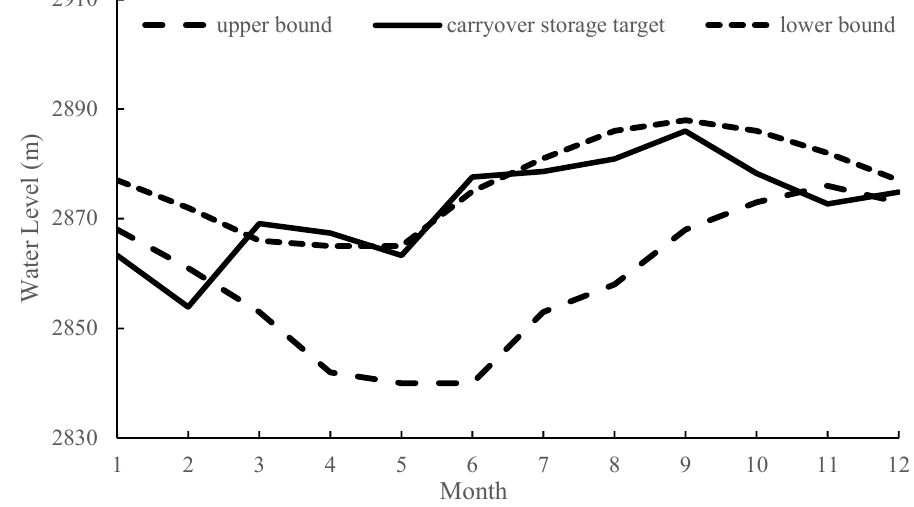
Figure 7. Optimization result of the carryover storage target.